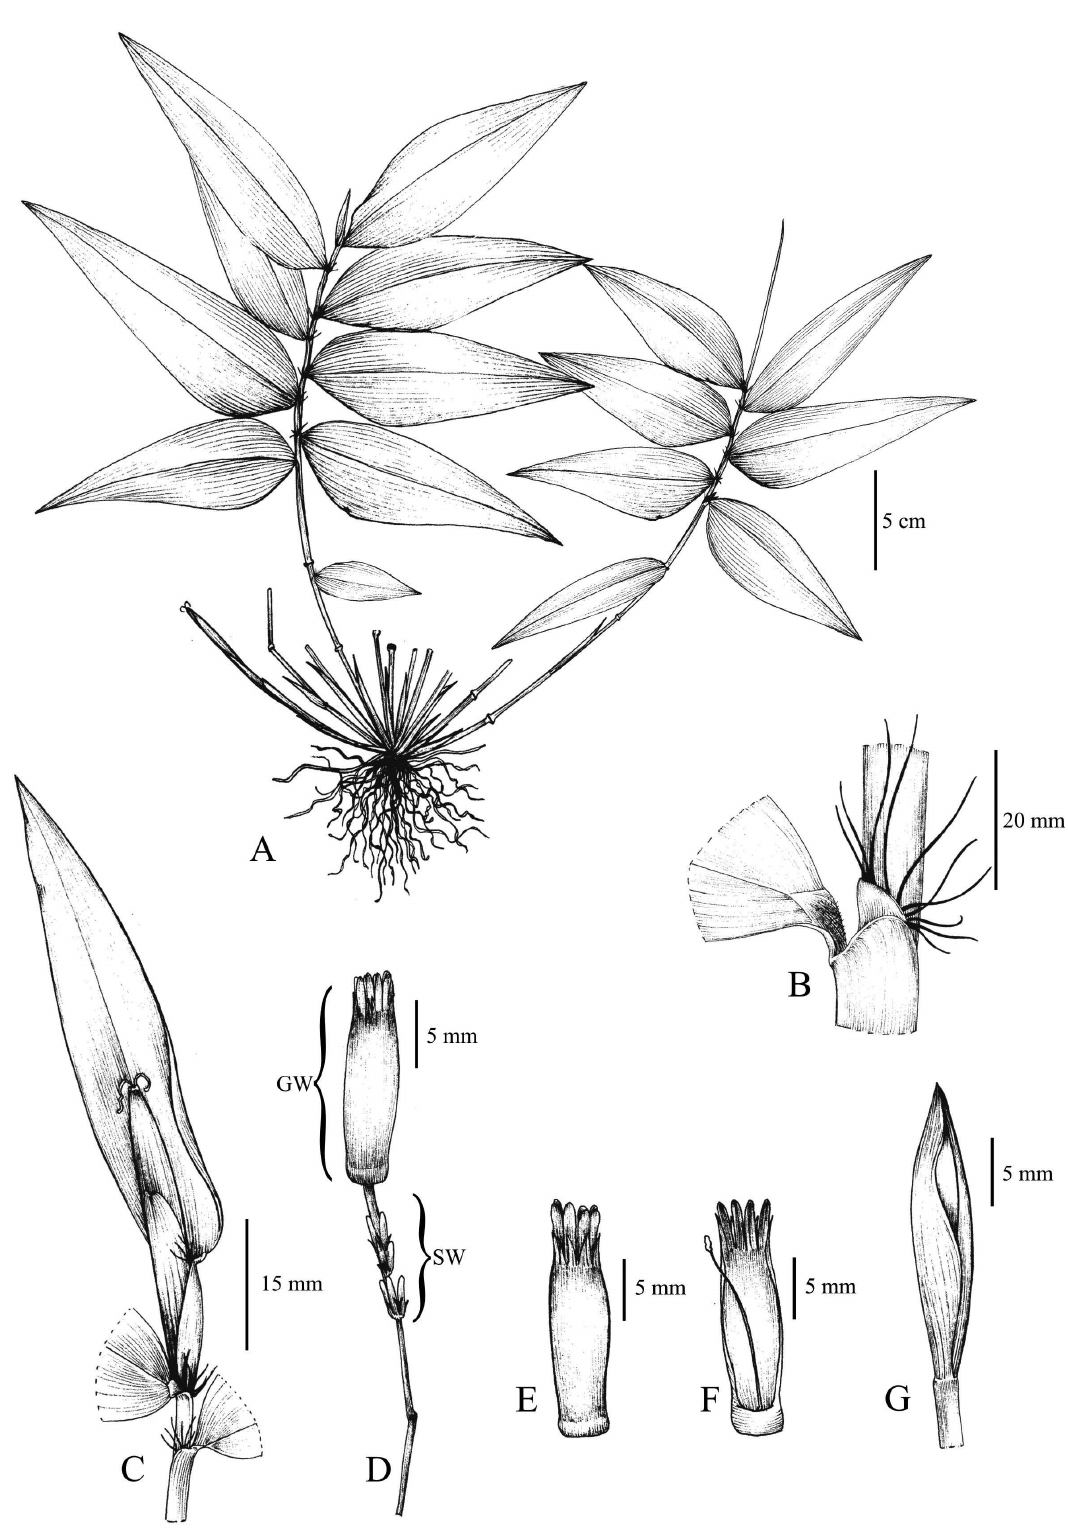
Figure 1 – Eremitis clarkiae . A . Habit. B . Detail of the leafy culm showing the fimbriae at the apex of the leaf sheaths. C . Leafy culm inflorescence enclosed by spathaceous bracts. D . Decumbent culm inflorescence with spathaceous bracts removed, showing a gynecandrous whorl (GW) above and three staminate whorls (SW) below. E – F . Gynecandrous whorl. E . Abaxial view of the staminate spikelets. F . Adaxial view of the staminate spikelets showing the rachis prolongation. G . Subterranean culm inflorescence enclosed by spathaceous bracts. From Ferreira & Lima 2213 (HUEFS). Illustration by Carla